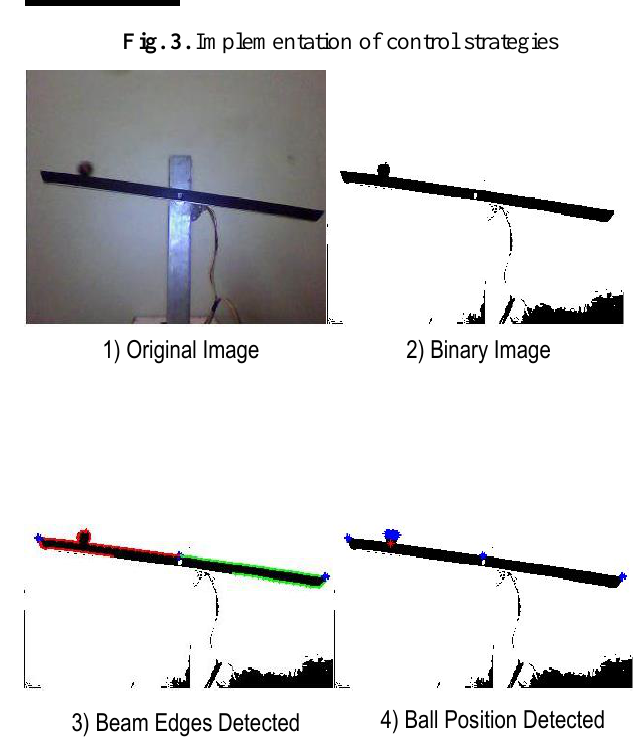
Fig. 4. Steps to acquire the position of a ball on the beam using image